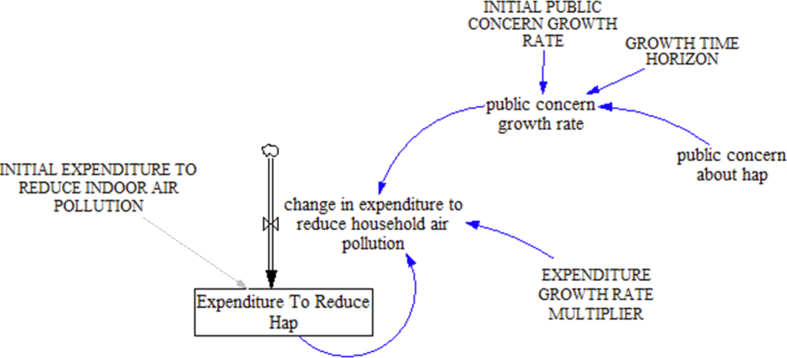
Formulation of expenditure.